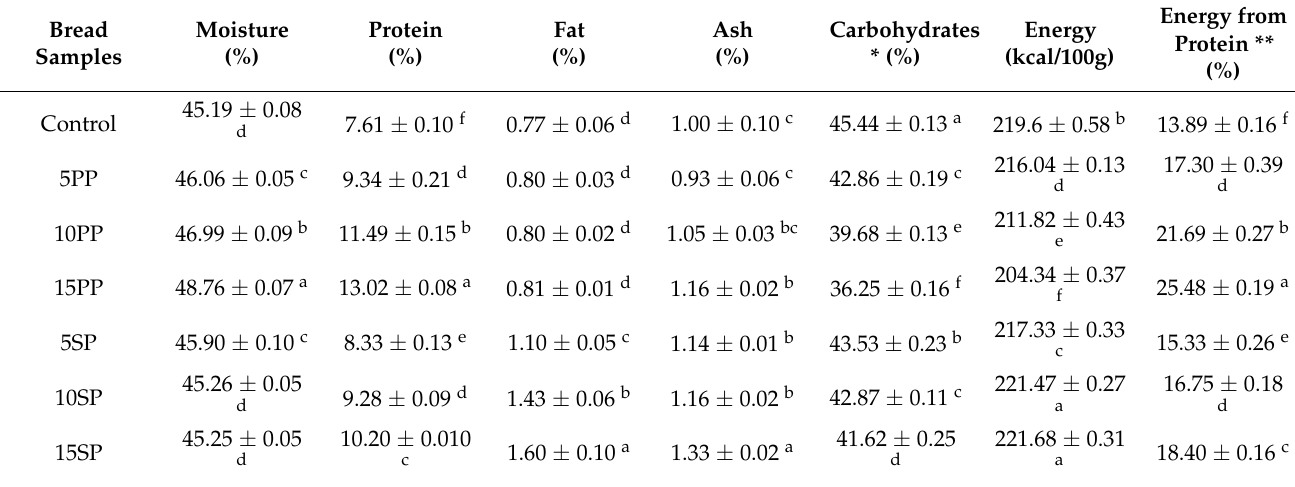
Table 2. Compositional analysis of the control and protein concentrate breads (expressed in % of the fresh bread). Bread Samples